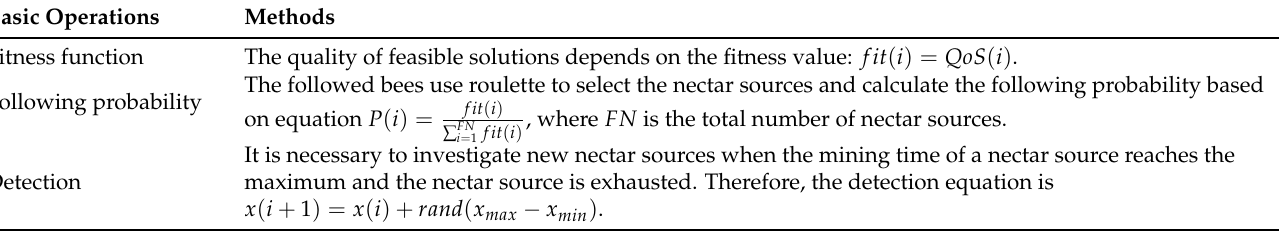
Table 2. ABC design